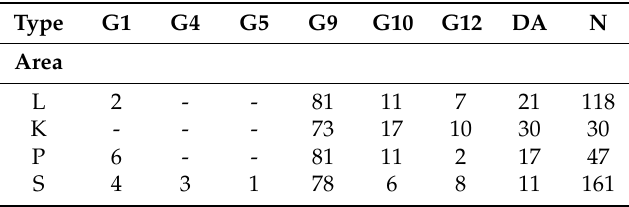
Table 2. The percentage (%) of pyrope paragenesis [25] in the samples from the studied areas. DA, diamond association [27]. N, number of grains